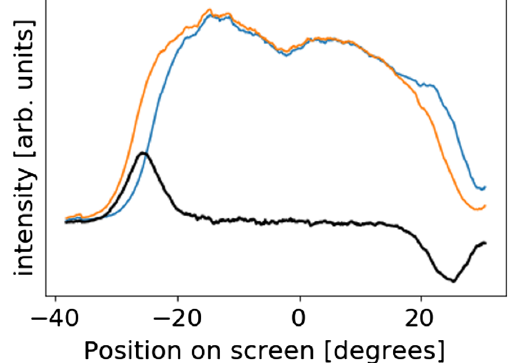
FIG. 9. Illustration of virtual slit concept. Two phase profiles (thin curves) are measured with the BSM camera for two dipole magnet settings separated by 0.05 A. The profiles plotted are obtained with a much wider slit (1 mm) than the standard 0.2 mm slit used for emittance measurements, and the phase profile nearly fills the camera frame. The heavy black line is the differential profile, which recovers two narrower profiles corresponding with the two edges of the wide